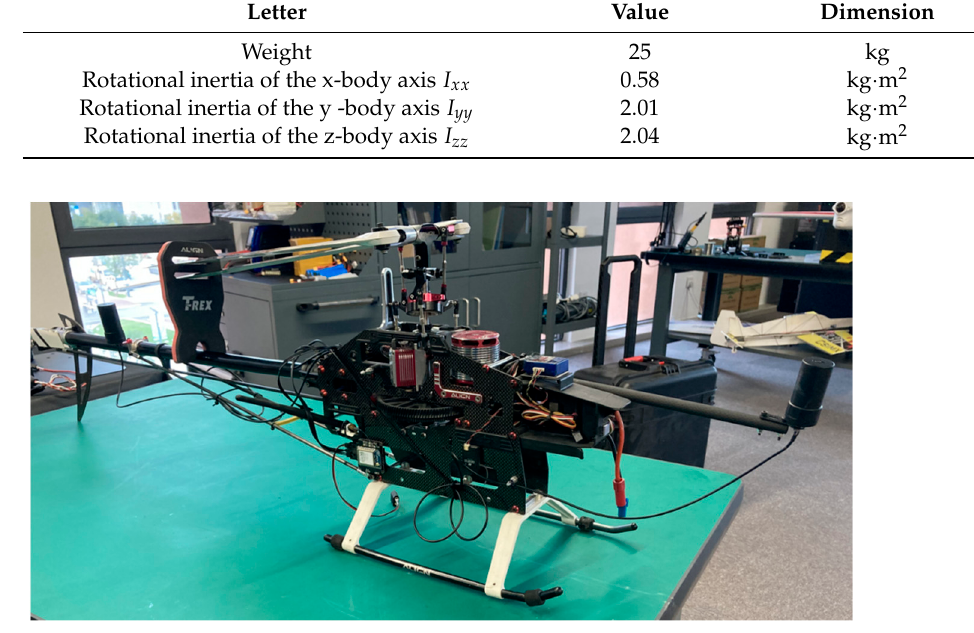
Figure 14. CAD assembly drawing of a small, unmanned helicopter.